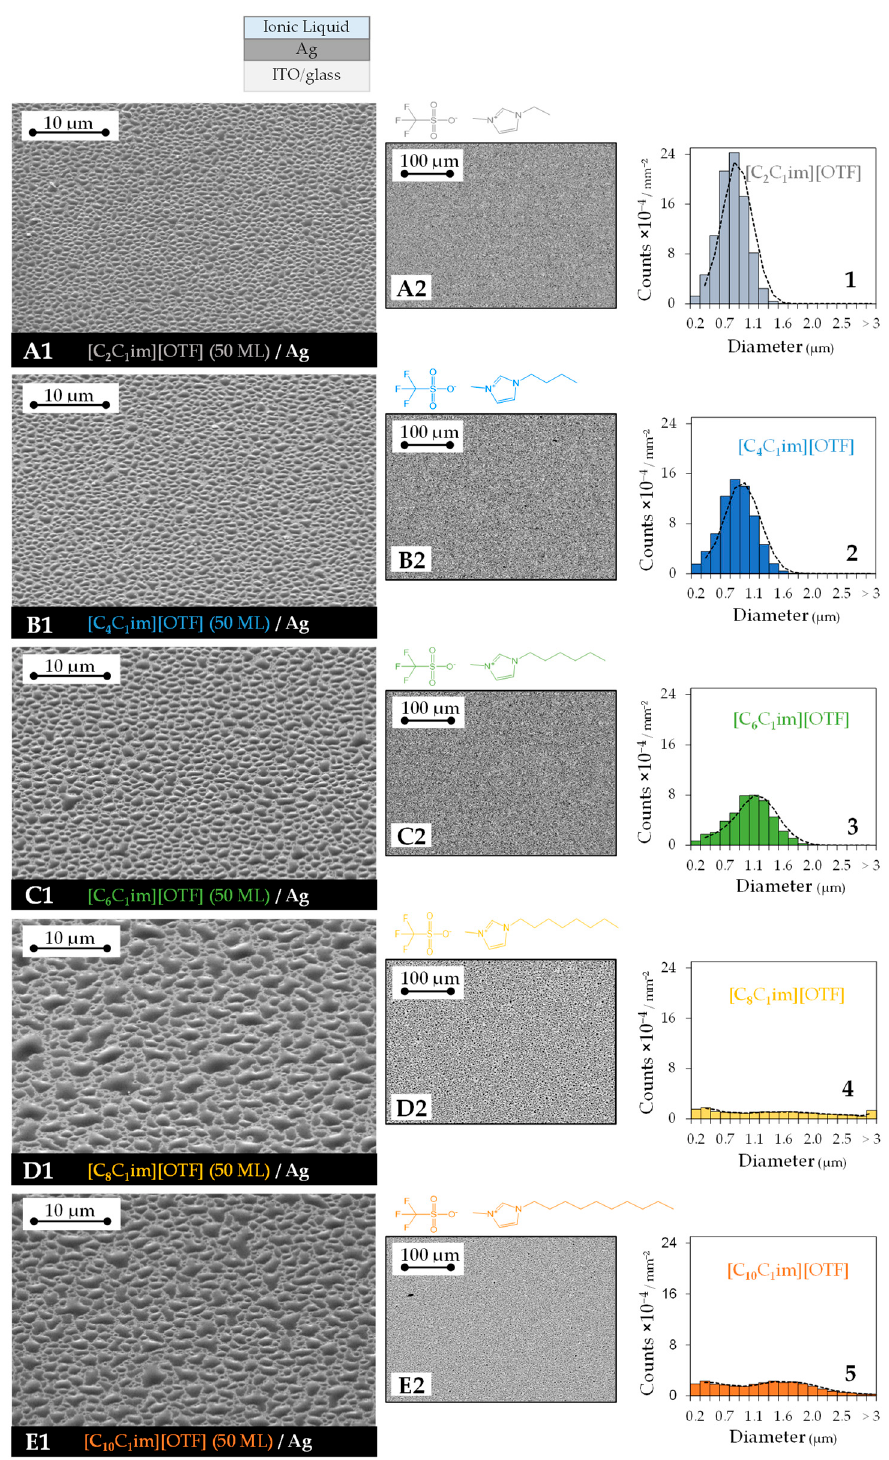
Figure 3. Micrographs acquired through high-resolution scanning electron microscopy of thin ionic liquid films (50 monolayers, ML) of [C 2 C 1 im][OTF] ( A1 , A2 ), [C 4 C 1 im][OTF] ( B1 , B2 ), [C 6 C 1 im][OTF] ( C1 , C2 ), [C 8 C 1 im][OTF] ( D1 , D2 ), and [C 10 C 1 im][OTF] ( E1 , E2 ) deposited onto surfaces of Ag/ITO/glass. Lateral views at 45° (magnification of 5000×) obtained by secondary electron imaging ( A1 – E1 ) and top views (magnification of 500×) obtained by backscattered electron imaging ( A2 – E2 ). The histograms (inserts 1, 2, 3, 4, and 5) present the droplet´s size distribution for each sample.